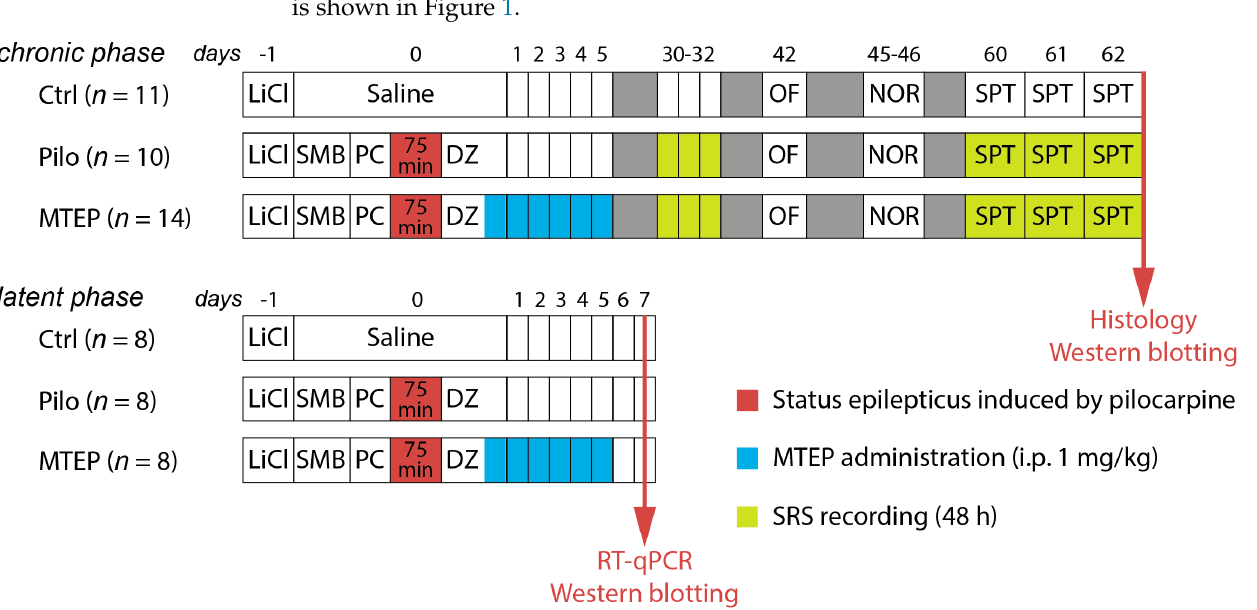
Figure 1. Experimental design. Pilo: rats administered with pilocarpine, MTEP: rats administered with pilocarpine and then treated with MTEP, LiCl: lithium chloride, SMB: ( − )-scopolamine methyl bromide, DZ: diazepam, OF: open field test, NOR: novel object recognition, SPT: sucrose preference test, SRS: spontaneous recurrent seizure, qPCR: reverse transcription followed by a quantitative polymerase chain reaction, WB: Western blotting.